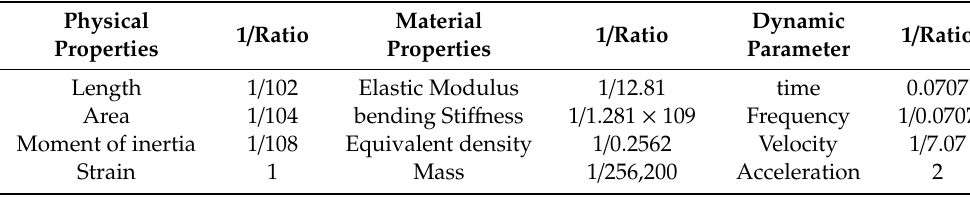
Table 2. Similitude ratios of the scale bridge